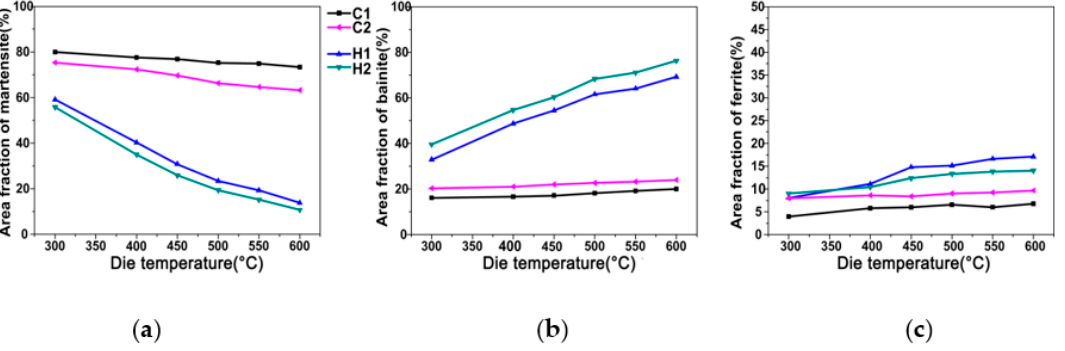
Figure 12. The area fraction under different tool temperatures of: ( a ) martensite, ( b ) bainite, and ( c ) ferrite.